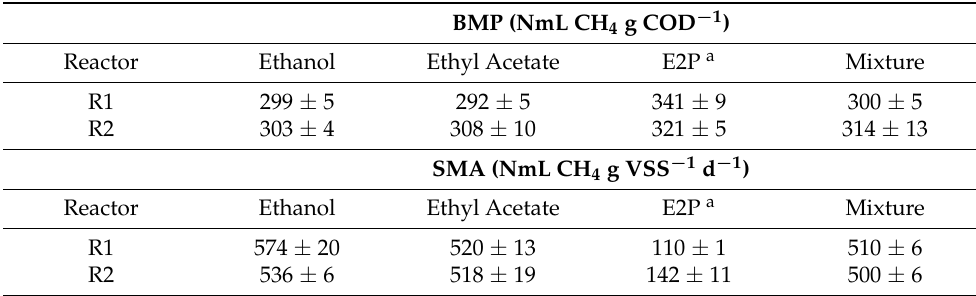
Table 2. Biochemical methane potential and specific methanogenic activity of the granular sludge of each reactor at the end of the